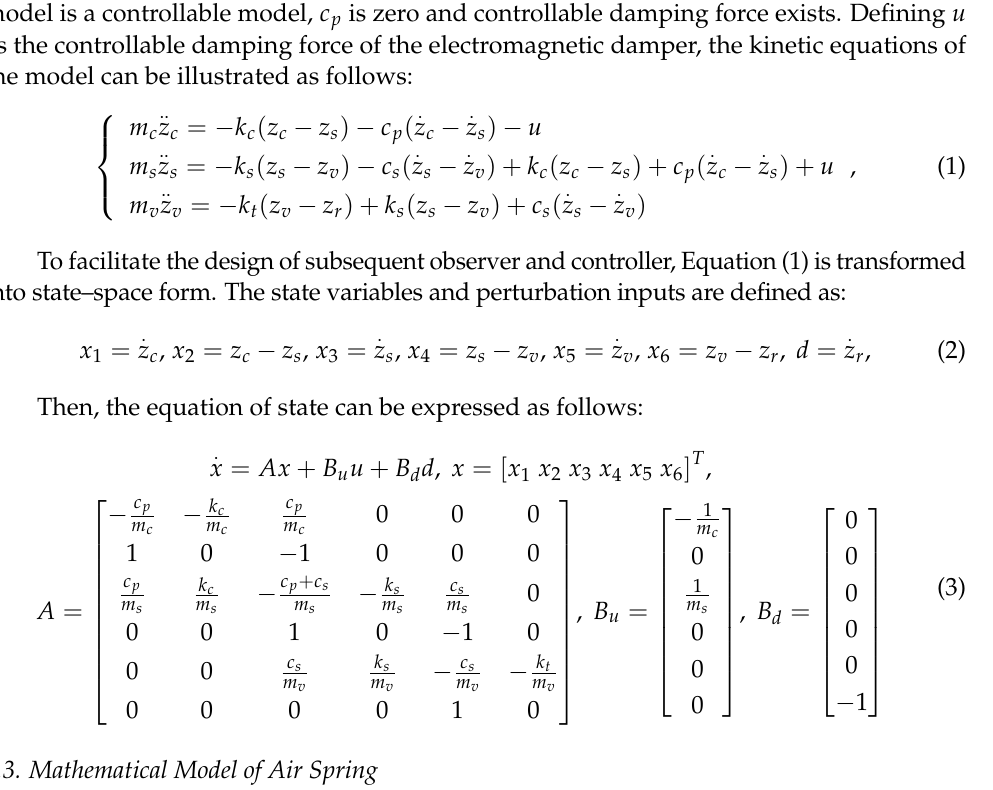
Table 1. Parameter values of the quarter-cab car suspension model. Symbol Value m c 794.5 kg m s 2364 kg m v k s k t 1,728,000 N/m c p 2000 N · s/m c s 12,000 N ·